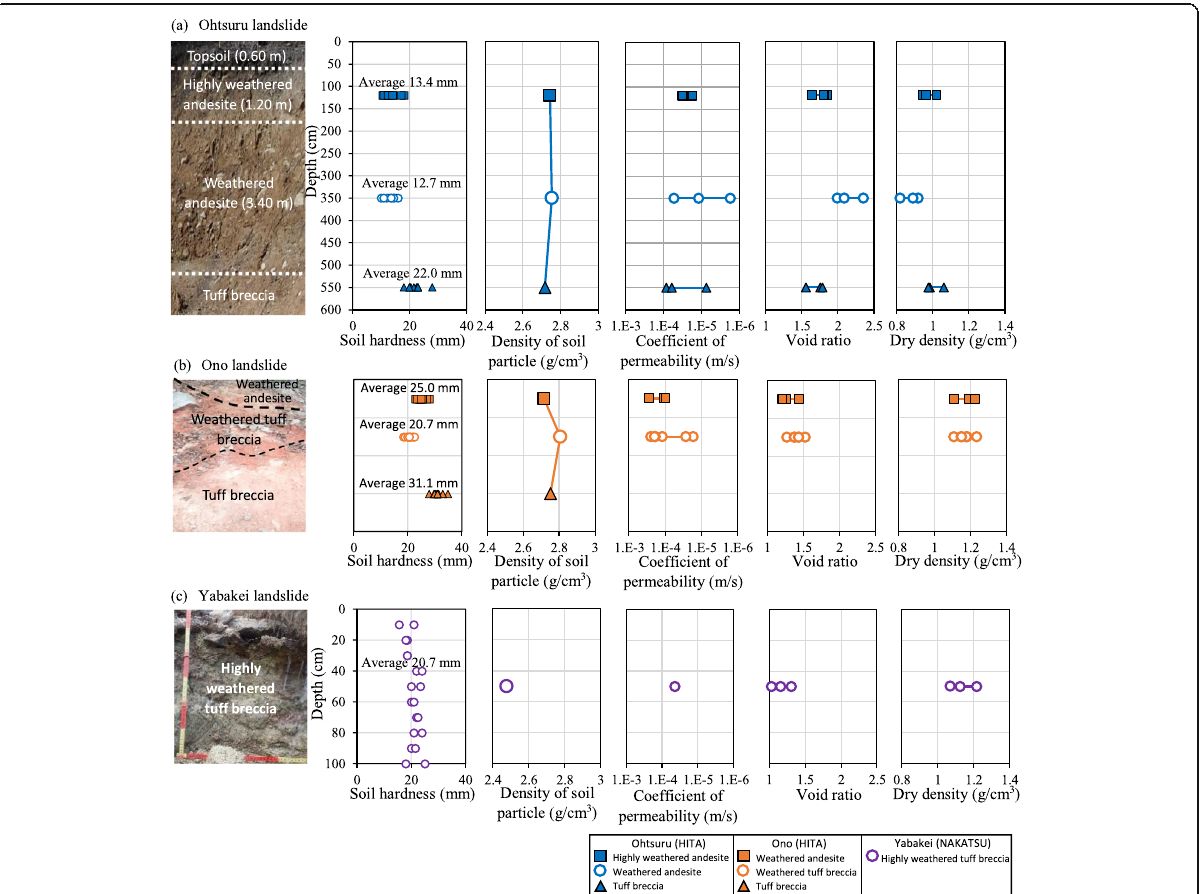
Fig. 9 Soil stratigraphy on the field, soil hardness, and saturated permeability properties values in ( a ) Ohtsuru landslide, ( b ) Ono landslide, ( c ) Yabakei landslide